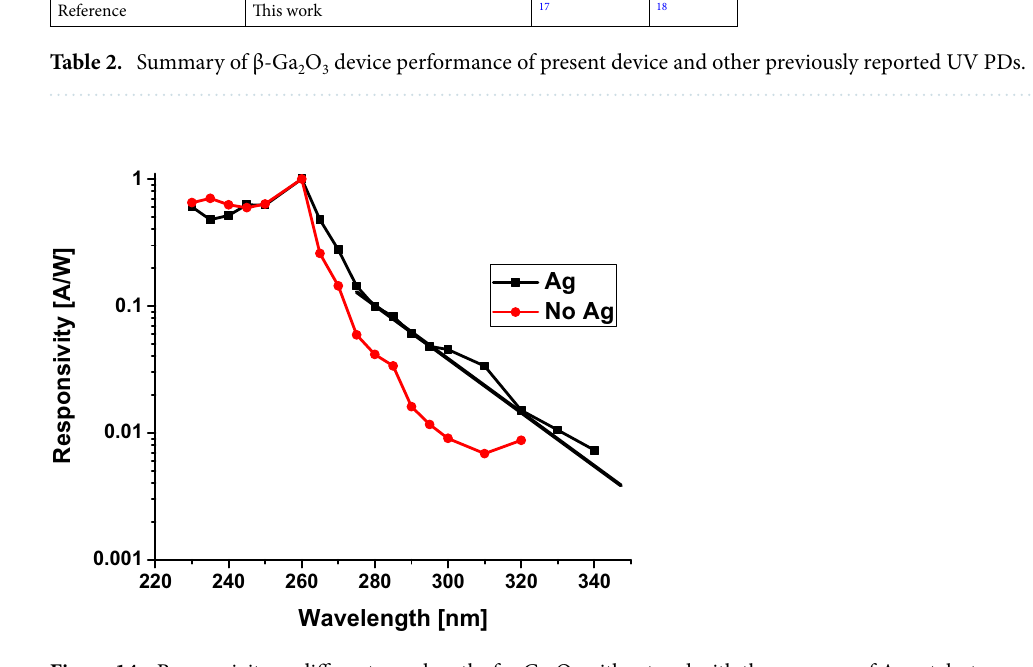
Figure 14. Responsivity vs different wavelengths for Ga 2 O 3 without and with the presence of Ag